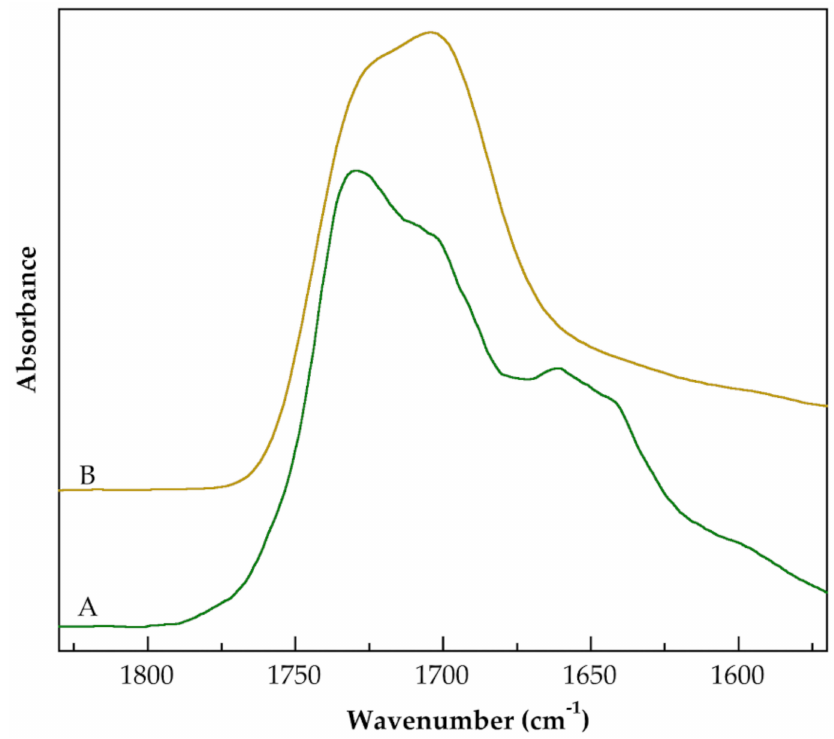
Figure 9. Partial FT-IR spectra centered in 1570–1830 cm − 1 region of the purified Nano 6 ( A ) and of the Nano 6 at the end of hydrocortisone release ( B